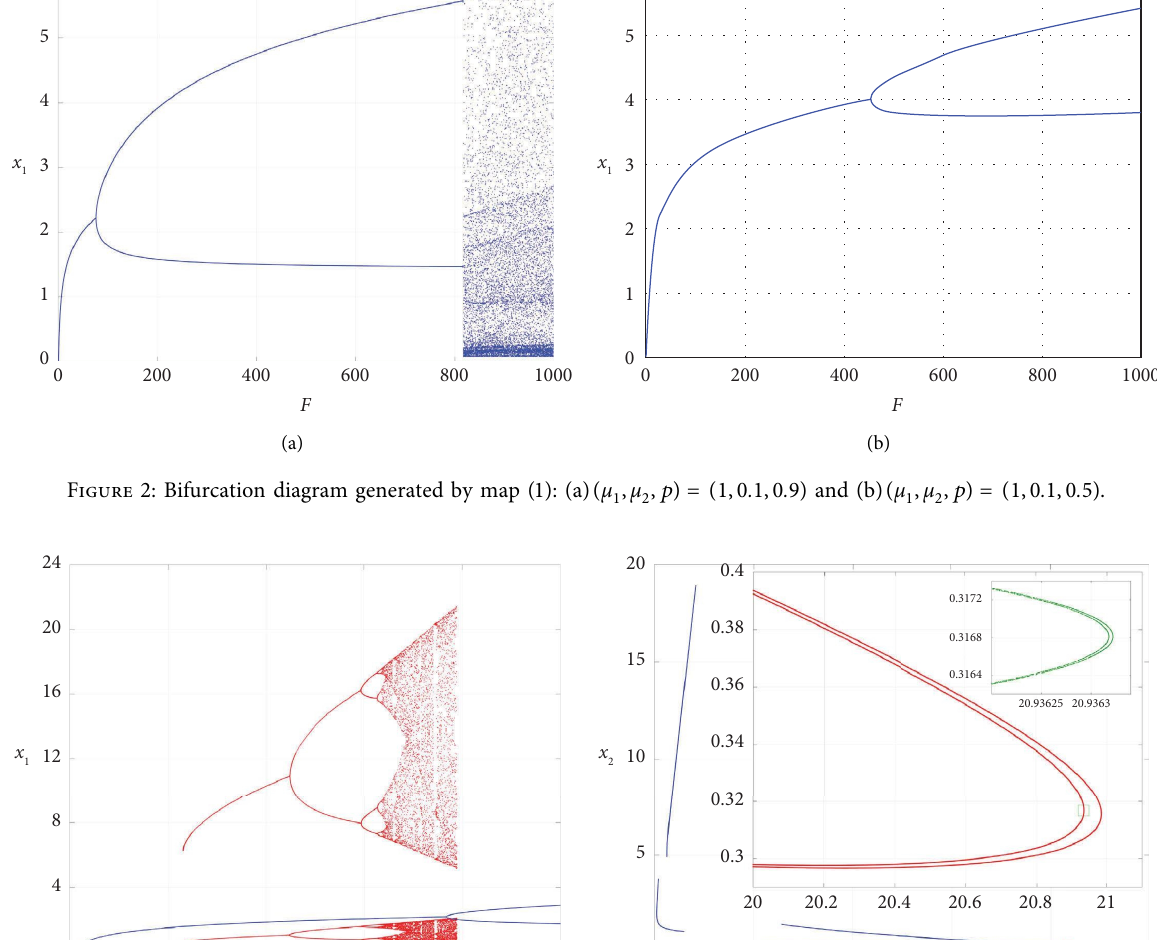
, μ ,p ) � ( 1 , 0 . 1 , 0 . 9 ) and diferent initial values than in 1 2